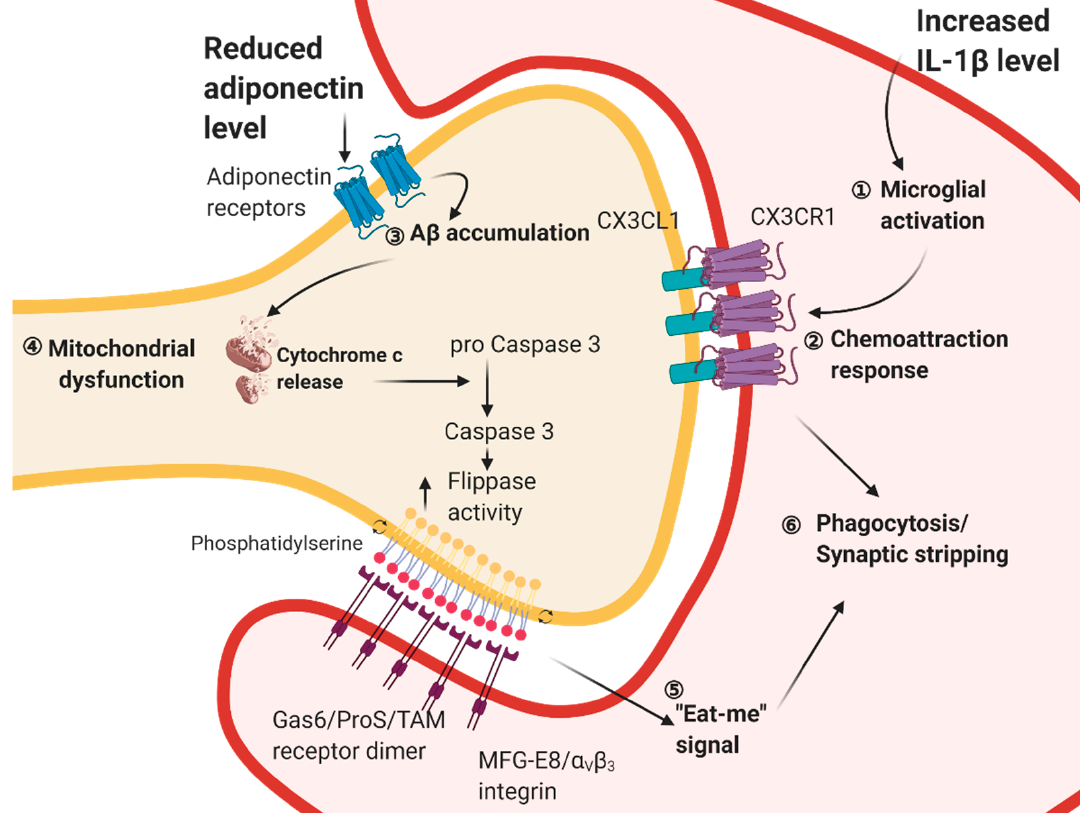
Figure 2. Intrinsic aberrant microglial activity and apoptotic spines can trigger synaptic stripping. 1 (cid:13) HFD-induced hippocampal IL-1 β elevation promotes the pro-inflammatory M1 phenotype in microglia. 2 (cid:13) The aberrant microglia are attracted by CX3CL1 (Fractalkine) from the dendritic spine, which is recognized by the microglial CX3CR1. On the other hand, 3 (cid:13) reduced adiponectin level induces the accumulation of β -amyloid in the hippocampus. 4 (cid:13) A β accumulation causes mitochondrial dysfunction with the reduced mitochondrial membrane potential as well as the increased oxida- tive stress. The apoptotic mitochondrial releases cytochrome c which can activate flippase activity through caspase 3. 5 (cid:13) Phosphatidylserine located at the outer membrane of the phospholipid bilayer are served as an ‘eat-me’ signal, which is recognized by the receptors on the microglia. 6 (cid:13) Together, both aberrant microglial activity and malfunctioned neuronal mitochondria can trigger synaptic stripping by the microglia. Created with